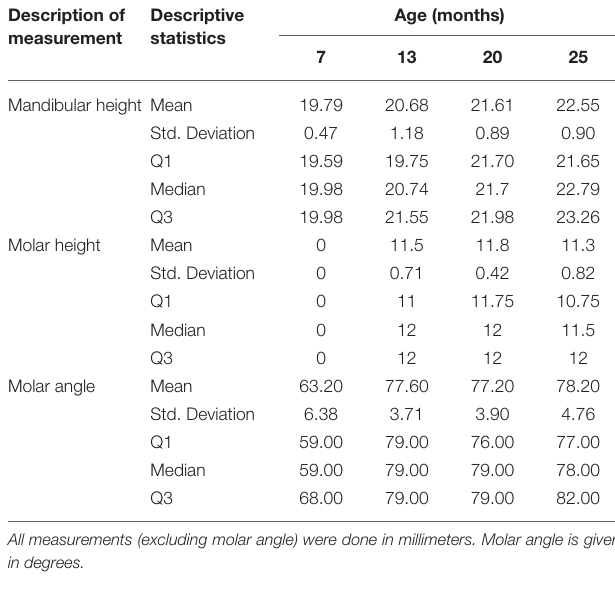
TABLE 5 | The descriptive statistics for each of the 13 calculated indices for the skull measurements of five cheetah cubs at each age